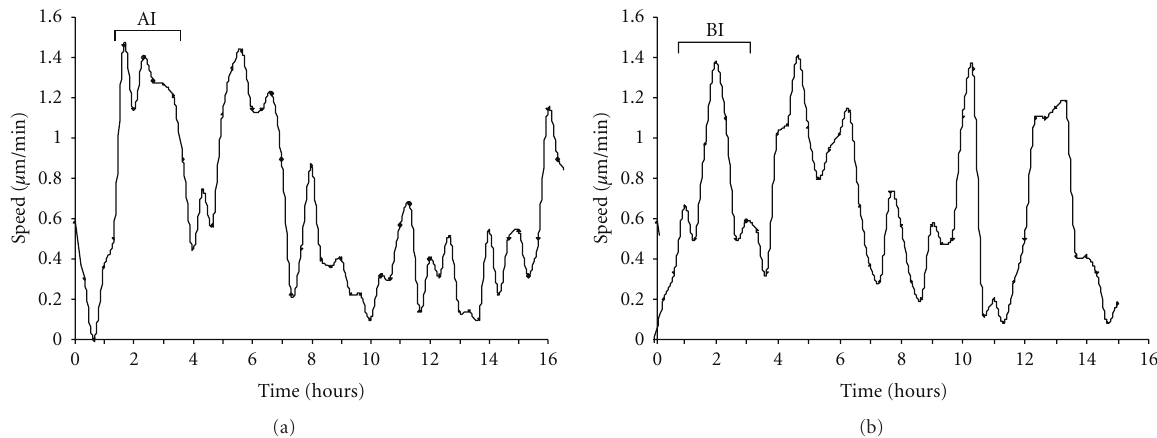
Figure 1: Characterization of B16F1 melanoma cell migration cycles. Variations in speed for a representative cell plated on (a) 5 μ g/mL laminin or (b) 2.5 μ g/mL fibronectin. Speeds were determined for every 20 min time period over 16 hours of analysis and plotted versus time to show the extent of variation in rate. AI and BI show the time window during the cell migration cycle, respectively that are analyzed in Figure